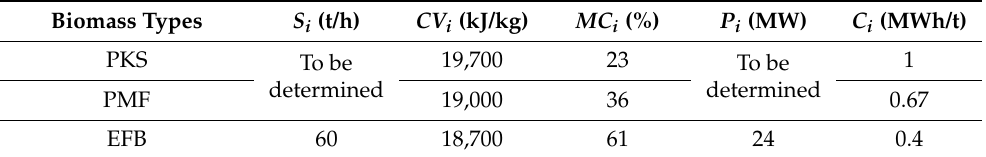
Table 3. Data for biomass in Example 1.